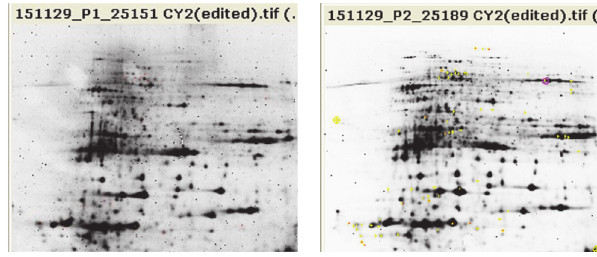
Figure 4: Overview of the fluorescence scans, preparative